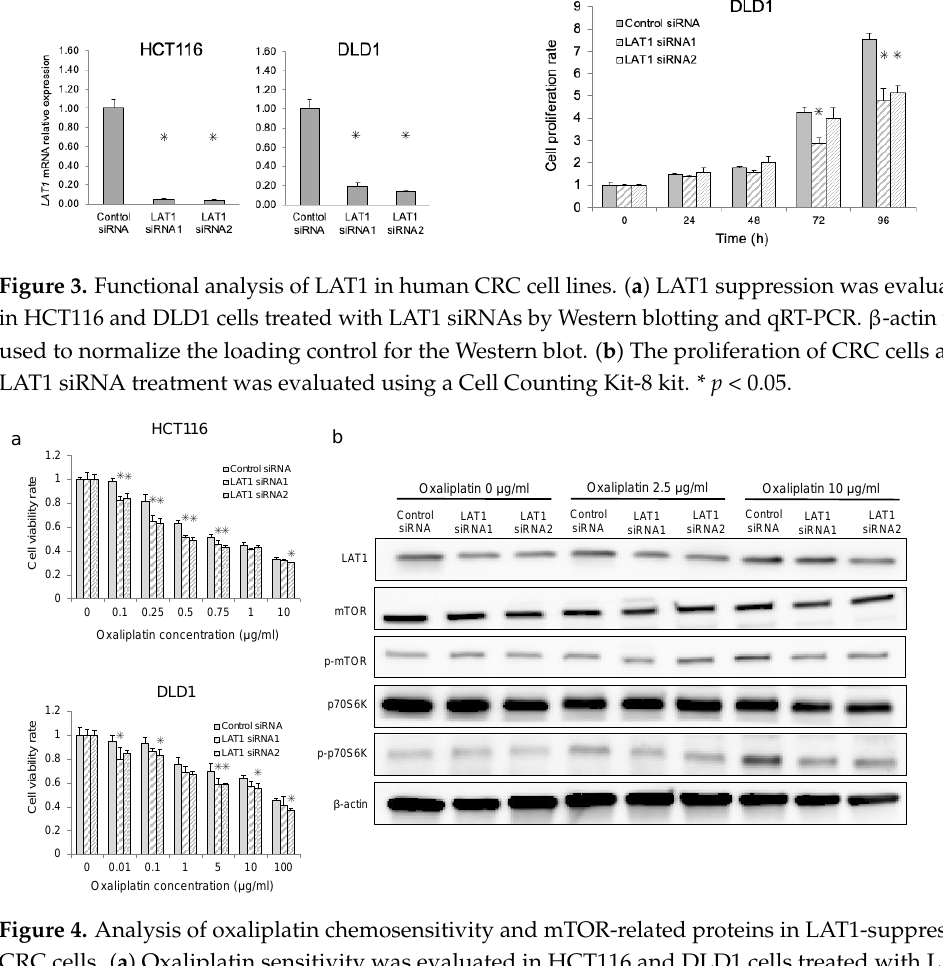
Figure 3. Functional analysis of LAT1 in human CRC cell lines. ( a ) LAT1 suppression was evaluated in HCT116 and DLD1 cells treated with LAT1 siRNAs by Western blotting and qRT-PCR. β-actin was used to normalize the loading control for the Western blot. ( b ) The proliferation of CRC cells after LAT1 siRNA treatment was evaluated using a Cell Counting Kit-8 kit. * p < 0.05.